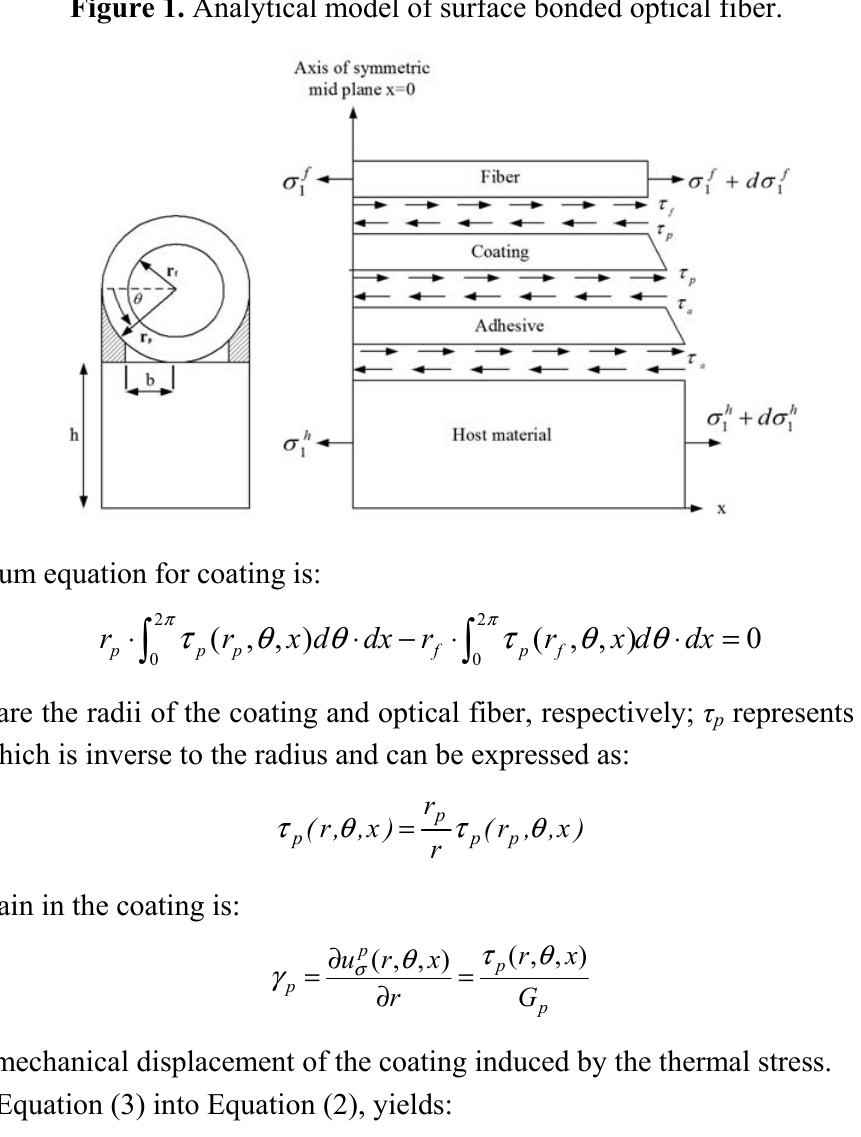
Figure 1. Analytical model of surface bonded optical